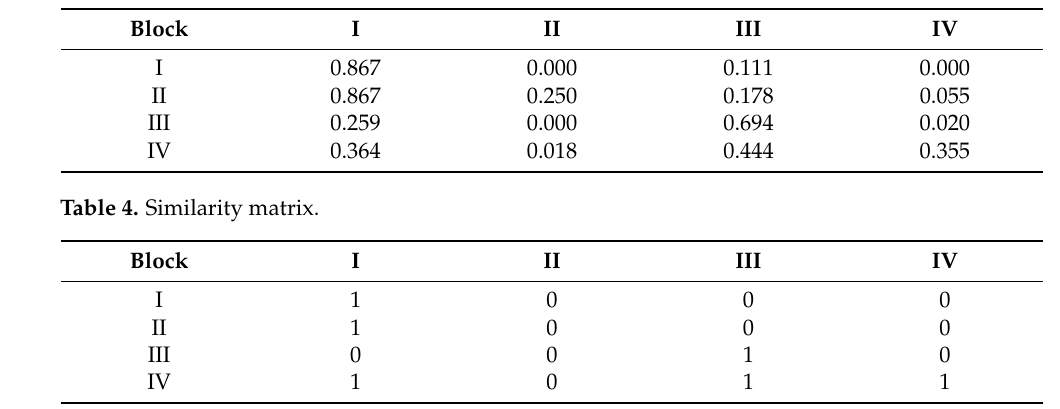
Table 3. Subgroup density matrix.